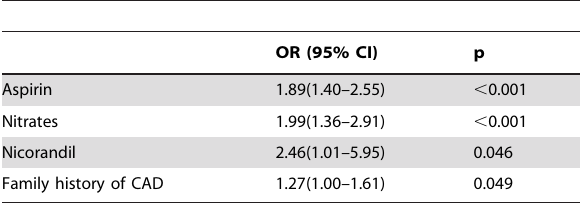
Figure 1. Levels of Creatine Kinase peak (IU/L) during the hospital phase.